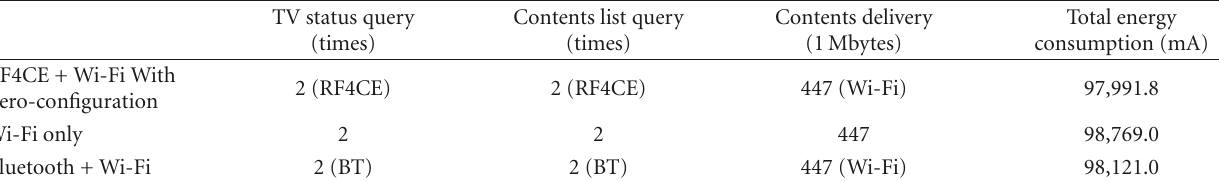
Table 2: Energy consumption for contents sharing